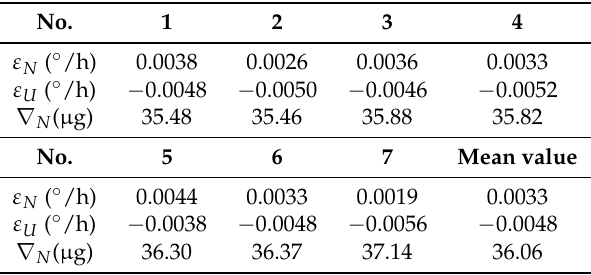
Table 7. The estimated biases of SINS.